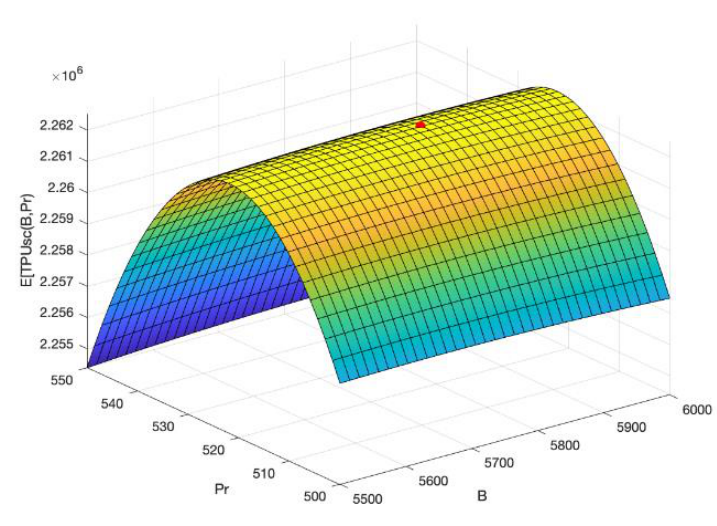
Figure 8. Concavity of E [ TPU SC ( B , p r )] w.r.t. B , p r .